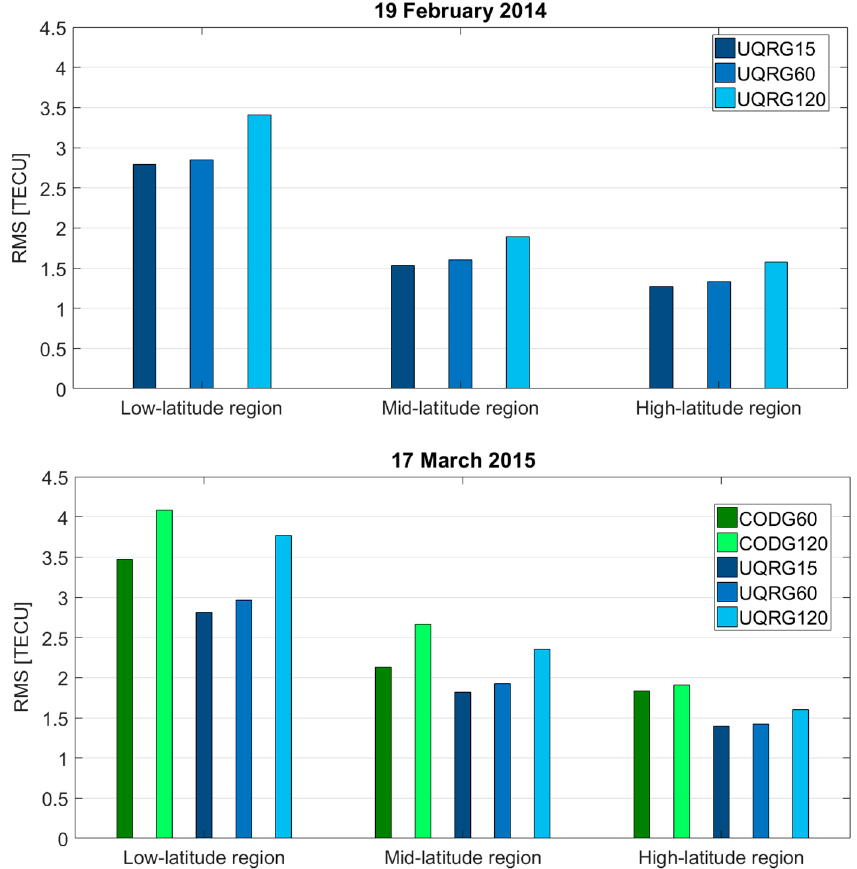
Figure 8. Daily RMS from GNSS-STEC comparisons over selected geomagnetic regions during analyzed storms. Table 7. Daily STD from Alt-VTEC comparisons during analyzed